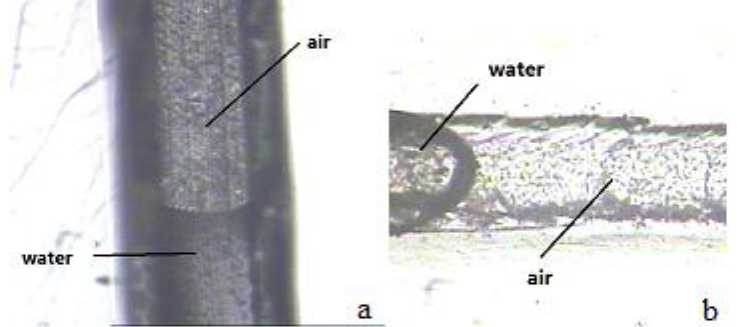
Figure 13. Surface wettability of microchannels with different roughness. ( a ) Surface wettability of a smooth microchannel; ( b ) Surface wettability of a rough